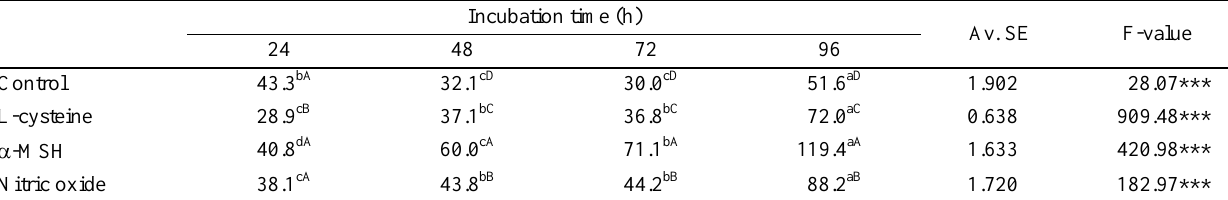
Table 3. Number of dead cells assessed by confocal microscopy after propidium iodide